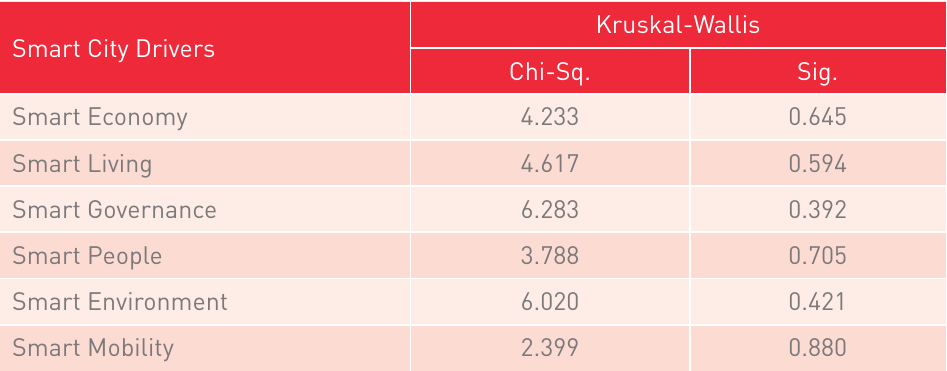
Kruskal-Wallis H-test of Role of Smart City Drivers in the Resilient City